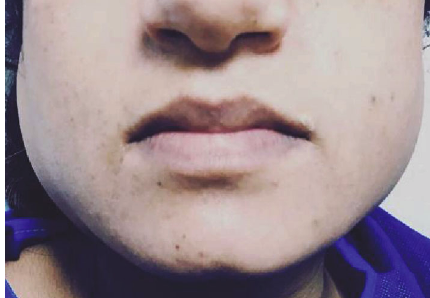
Figure 1: Front face view of the patient at 7 hours after surgery.